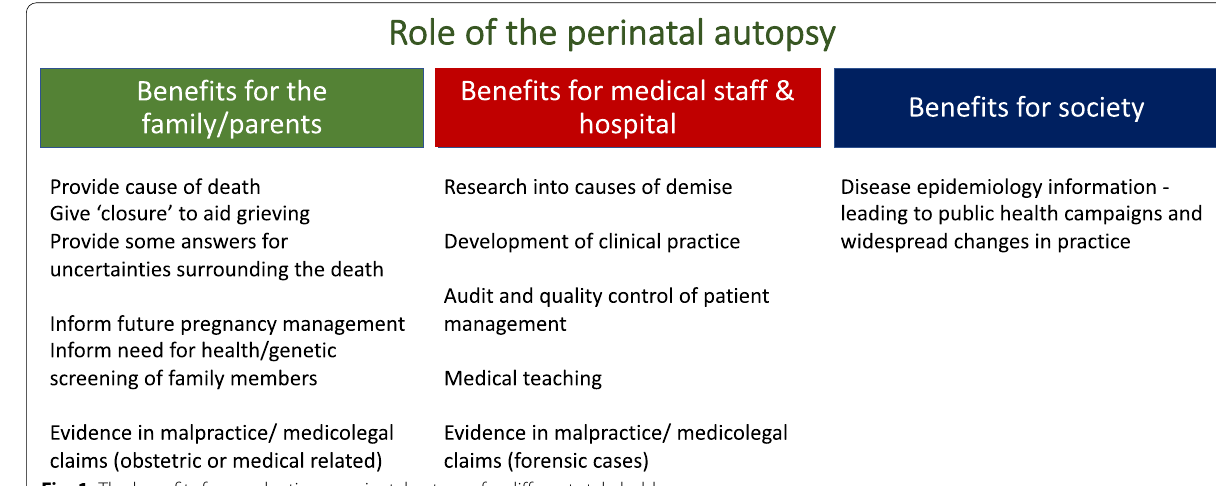
Fig. 1 The benefits for conducting a perinatal autopsy for different